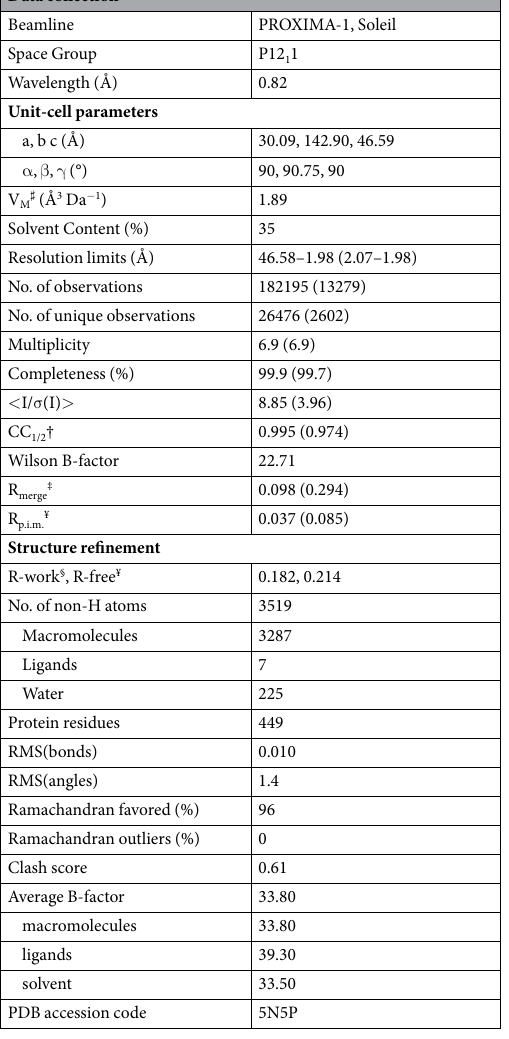
Table 1. X-ray diffraction data collection and refinement statistics for Rf CohScaB5-DocScaA. Values in parenthesis are for the highest resolution shell. # Matthews coefficient 50 . † CC 1/2 = the correlation between intensities from random half‐dataset (Diederichs & Karplus, 2013). ‡ R merge = Σ hkl Σ i |I i (hkl) − < I(hkl) > |/ Σ hkl Σ i I i (hkl) , where I i (hkl) is the i th intensity measurement of reflection hkl , including symmetry-related reflections and < I(hkl) > is its average. ¥ R p i